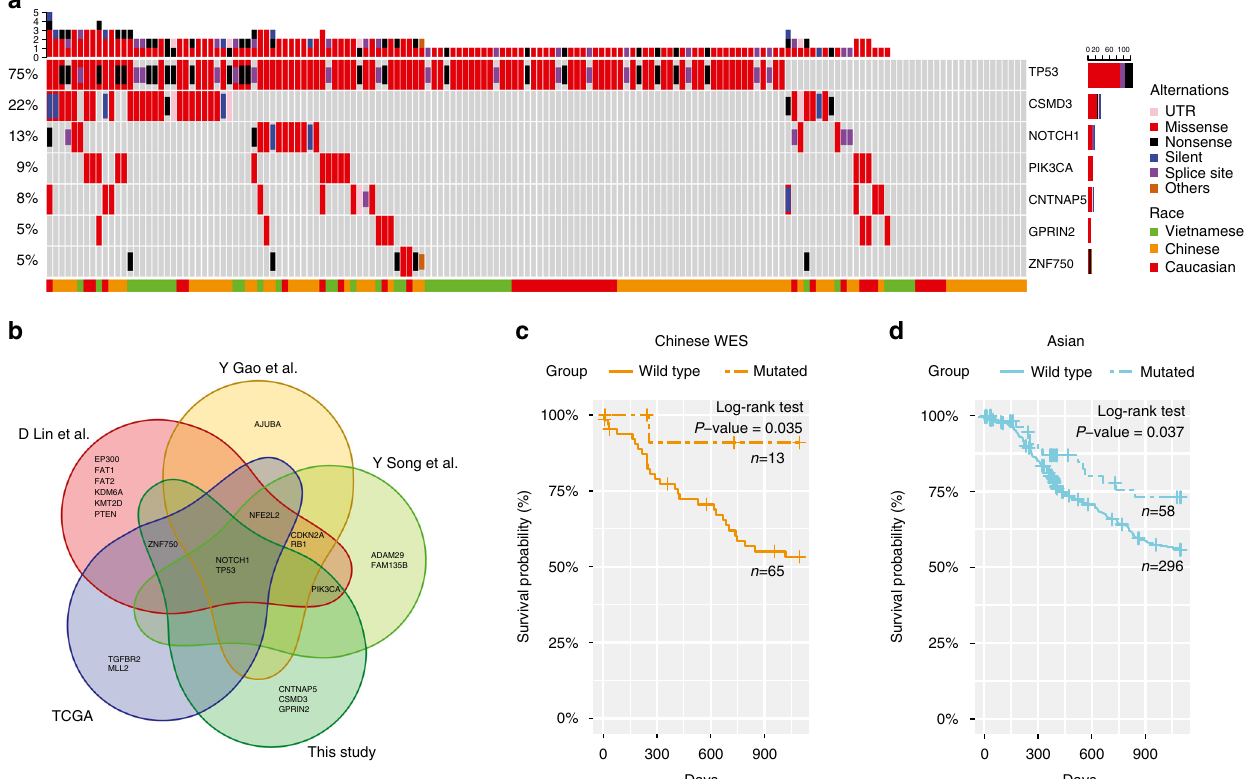
Fig. 2 Signi fi cantly mutated genes in ESCC. a Signi fi cantly mutated genes (SMGs) identi fi ed by MutSigCV on a combined cohort of Caucasian, Vietnamese, and Chinese WES samples. Each column denotes an ESCC patient, and each row is a gene. On top is the number of somatic mutations per sample. On the left are the mutation frequencies of each SMG. The bar plot on the right shows the composition of mutations in the gene. Genes are ordered by their mutation frequencies. b Overlap of SMGs reported by fi ve studies. c , d Kaplan – Meier curves according to the mutational status of CSMD3 gene in c 78 Chinese WES cases and d other 354 Asian cases (consisting of 41 Vietnamese WES cases and 313 Chinese targeted sequencing cases). Mutated groups show signi fi cantly better overall survival outcomes (log-rank